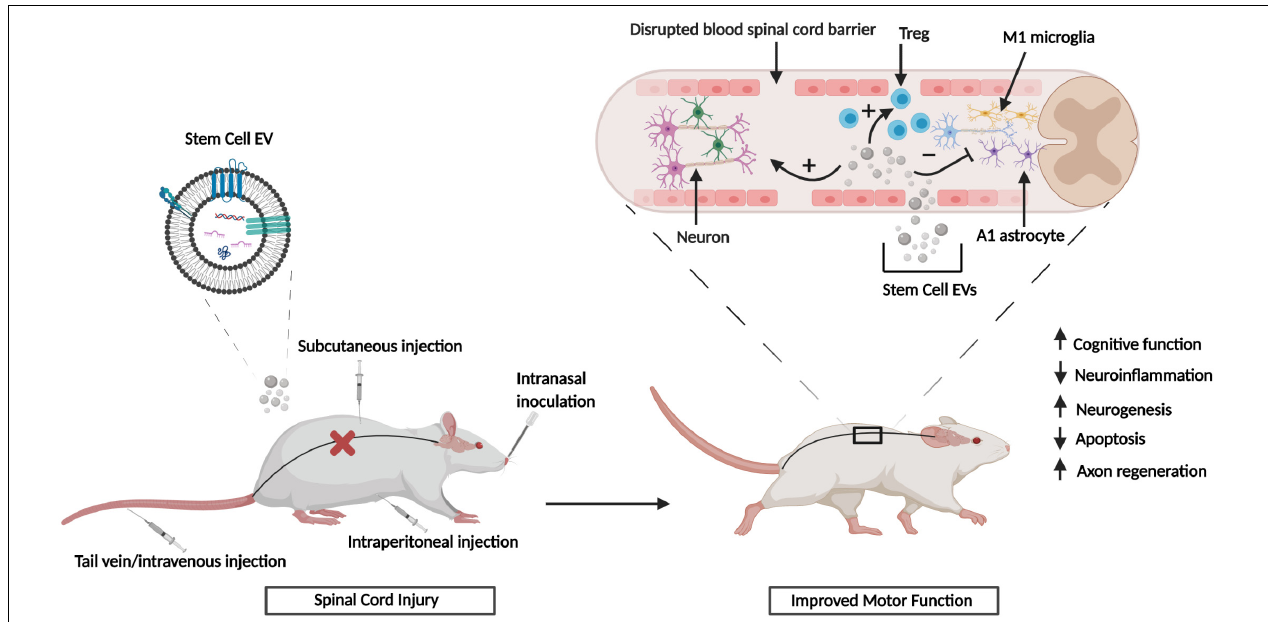
FIGURE 2 | Stem cell EV-mediated CNS repair in vivo . SCI results in the disruption of the blood spinal cord barrier. Upon injury, stem cell EVs can be administered via several different routes. Treatment with stem cell EVs is characterized by both functional and histological improvements. Figure adapted from Guo et al. (2019) and Riazifar et al.